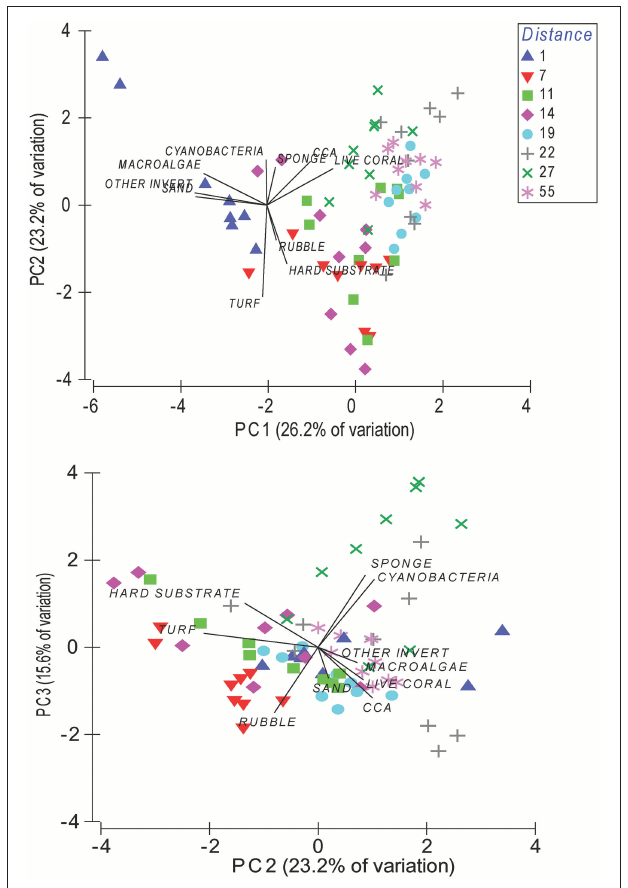
FIGURE 6 | Principal component analysis of benthic groups and substrate type for all sites indicated by distance from shore for 2012, 2013, and 2014 combined. PC1, PC2, and PC3 together account for 65% of the variation.